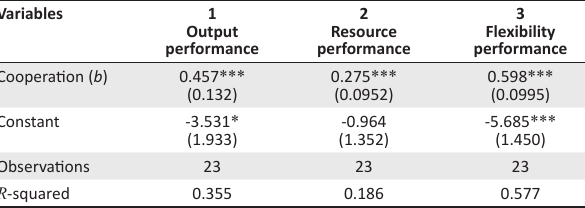
TABLE 2: The impact of humanitarian strategies on performance variables 1–3.